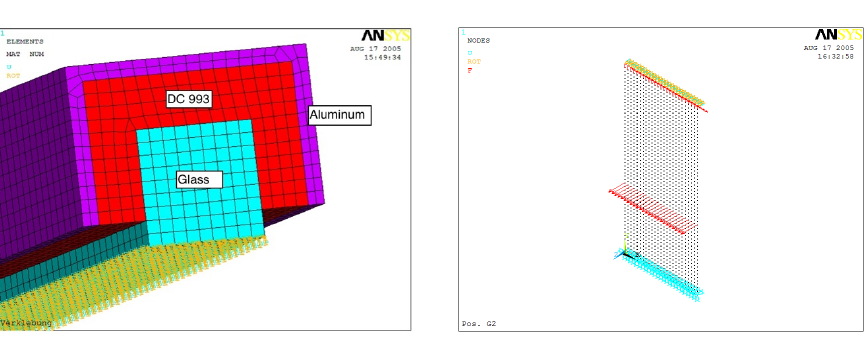
Figure 4a: FEA model, bonding. Figure 4b: FEA model, complete glass